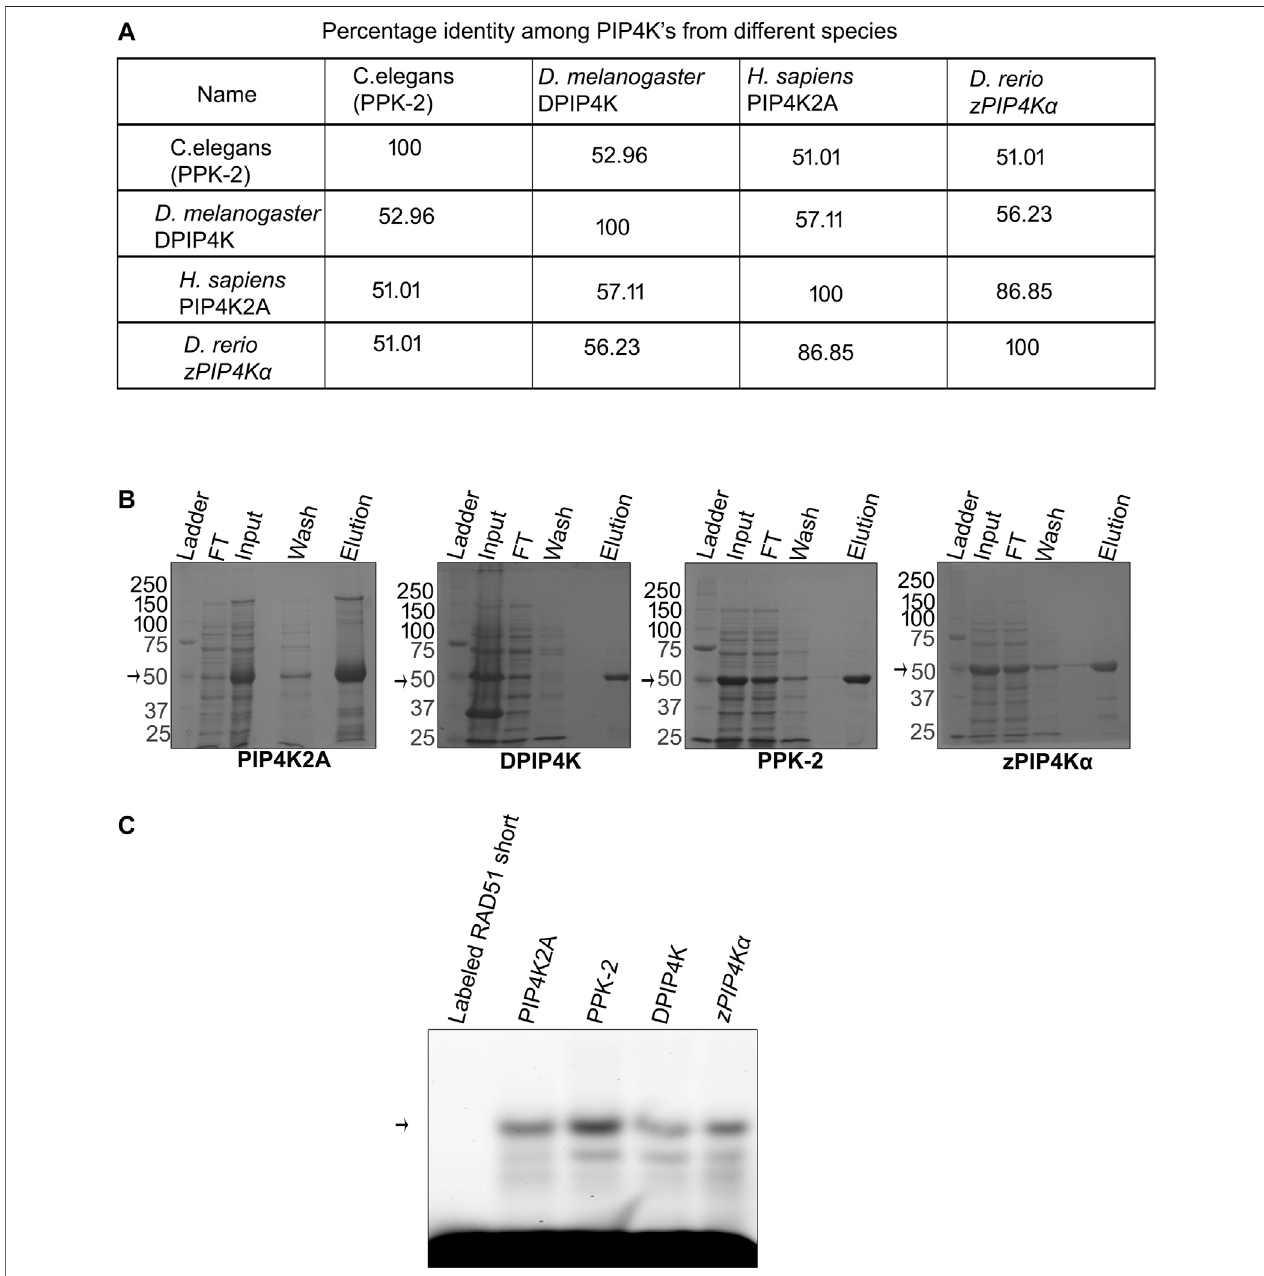
FIGURE3| RNAbindingactivity ofPIP4Kisconserved among thespecies. (A) .UsingClustalWsoftware, multiplesequence alignment wasdone,andpercentage identity was calculated for different PIP4K ’ s and is presented in a tabular form. (B) Recombinant proteins were induced by 0.5 mM IPTG and puri fi ed using nickel chelating resin. Purity was checked on 10% SDS page. (C) Recombinant PIP4K2A from human, D. melanogaster , C. elegans , and D. rerio was incubated with labeled RAD51-short for 1 h at 16 ° C. RNA binding activity was checked by resolving the complex and only labeled RNA on 1% agarose at 4 ° C ( n (cid:1) 3).